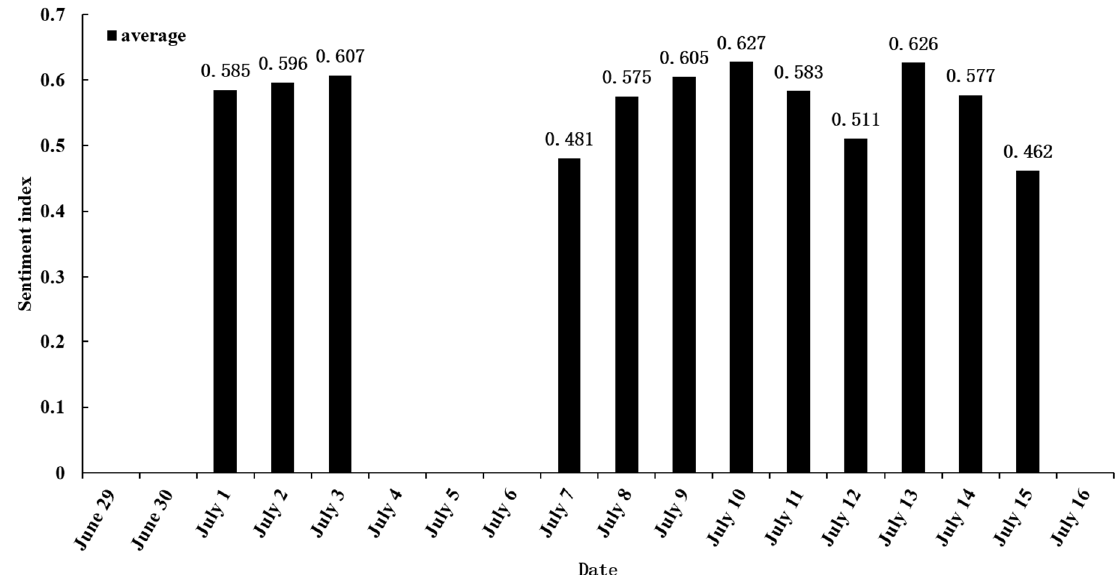
Figure 7. The temporal evolution of mood index.